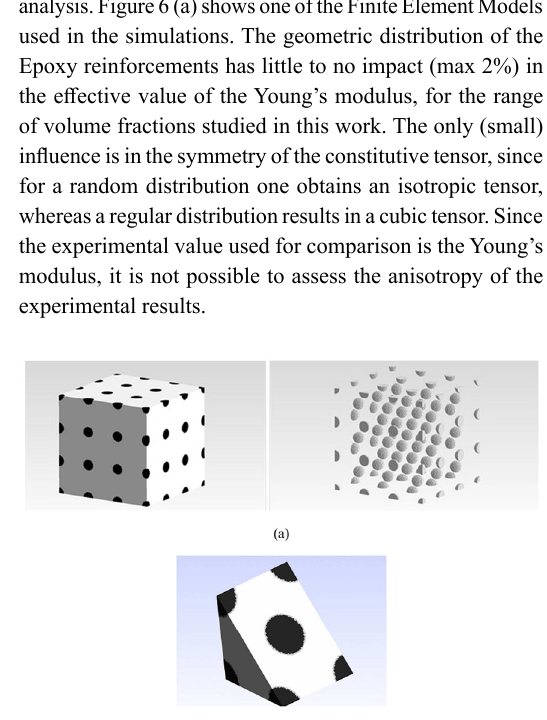
Figure 6. (a) Example of a Finite Element Model of the RVE used in the homogenization approach. Base material (white) and inclusions (black) on the left and a detailed view of the inclusions (right); (b) RVE used to simulate the effect of the interface (gray rims) between the matrix (white) and the reinforcement (black) on the homogenized Young's